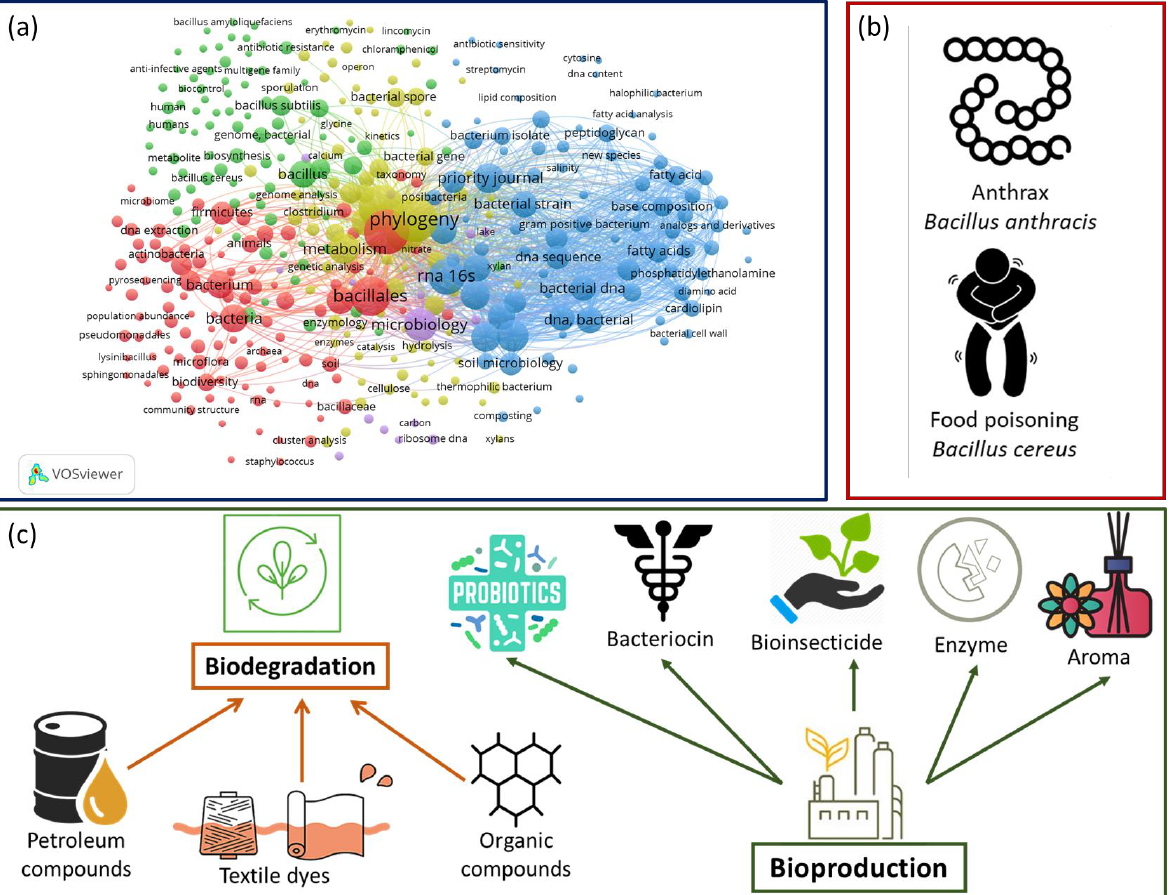
Figure 1. ( a ) The bibliometric map of Bacillales from 2000 to present, ( b ) their negative aspects on health, and ( c ) their positive aspects in the biodegradation and biorefinery